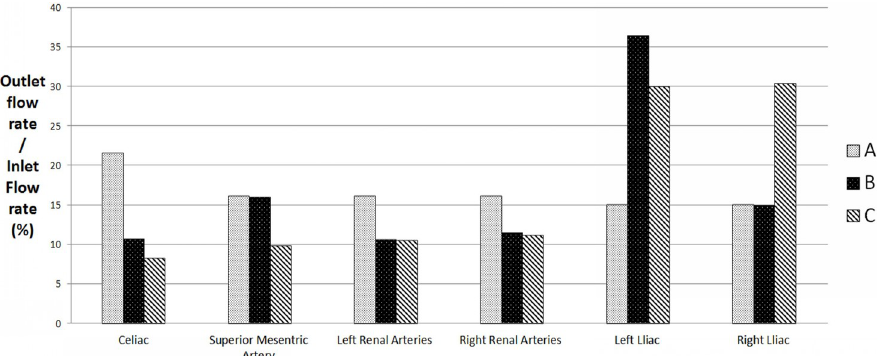
Fig 5. Histograms of the flow split for each branch artery A) healthy abdominal aorta; B) RVR using unilateral quar- furcated graft; C) RVR using bilateral bi-furcated